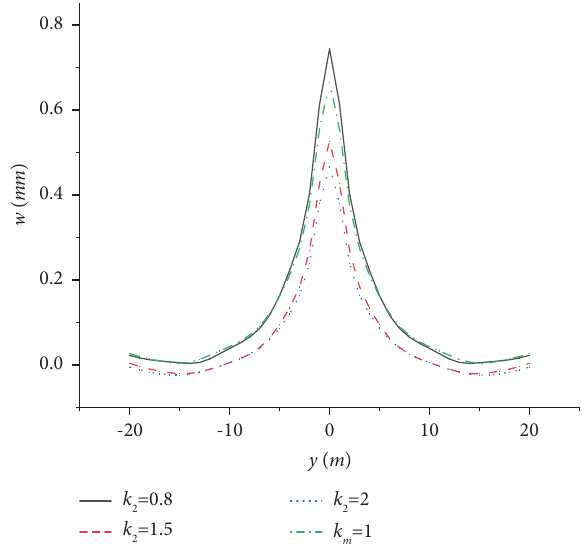
Figure 7: Plate deformation curves in y- direction due to E